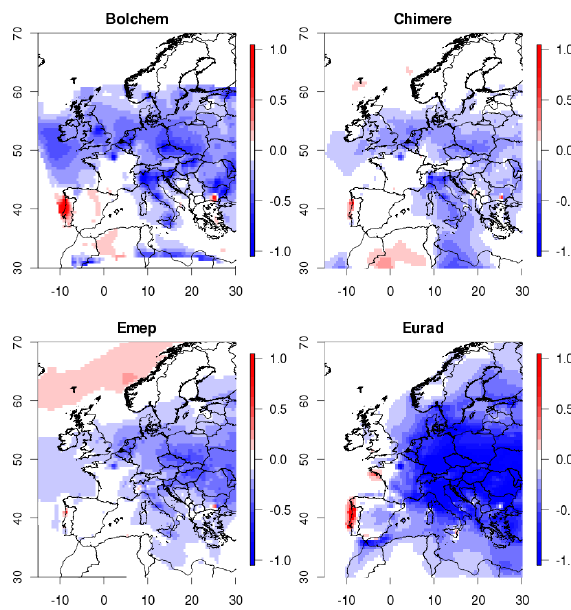
Figure 11 Same as Figure 7 for PM10. Fig. 11. Same as Fig. 7 for PM 10